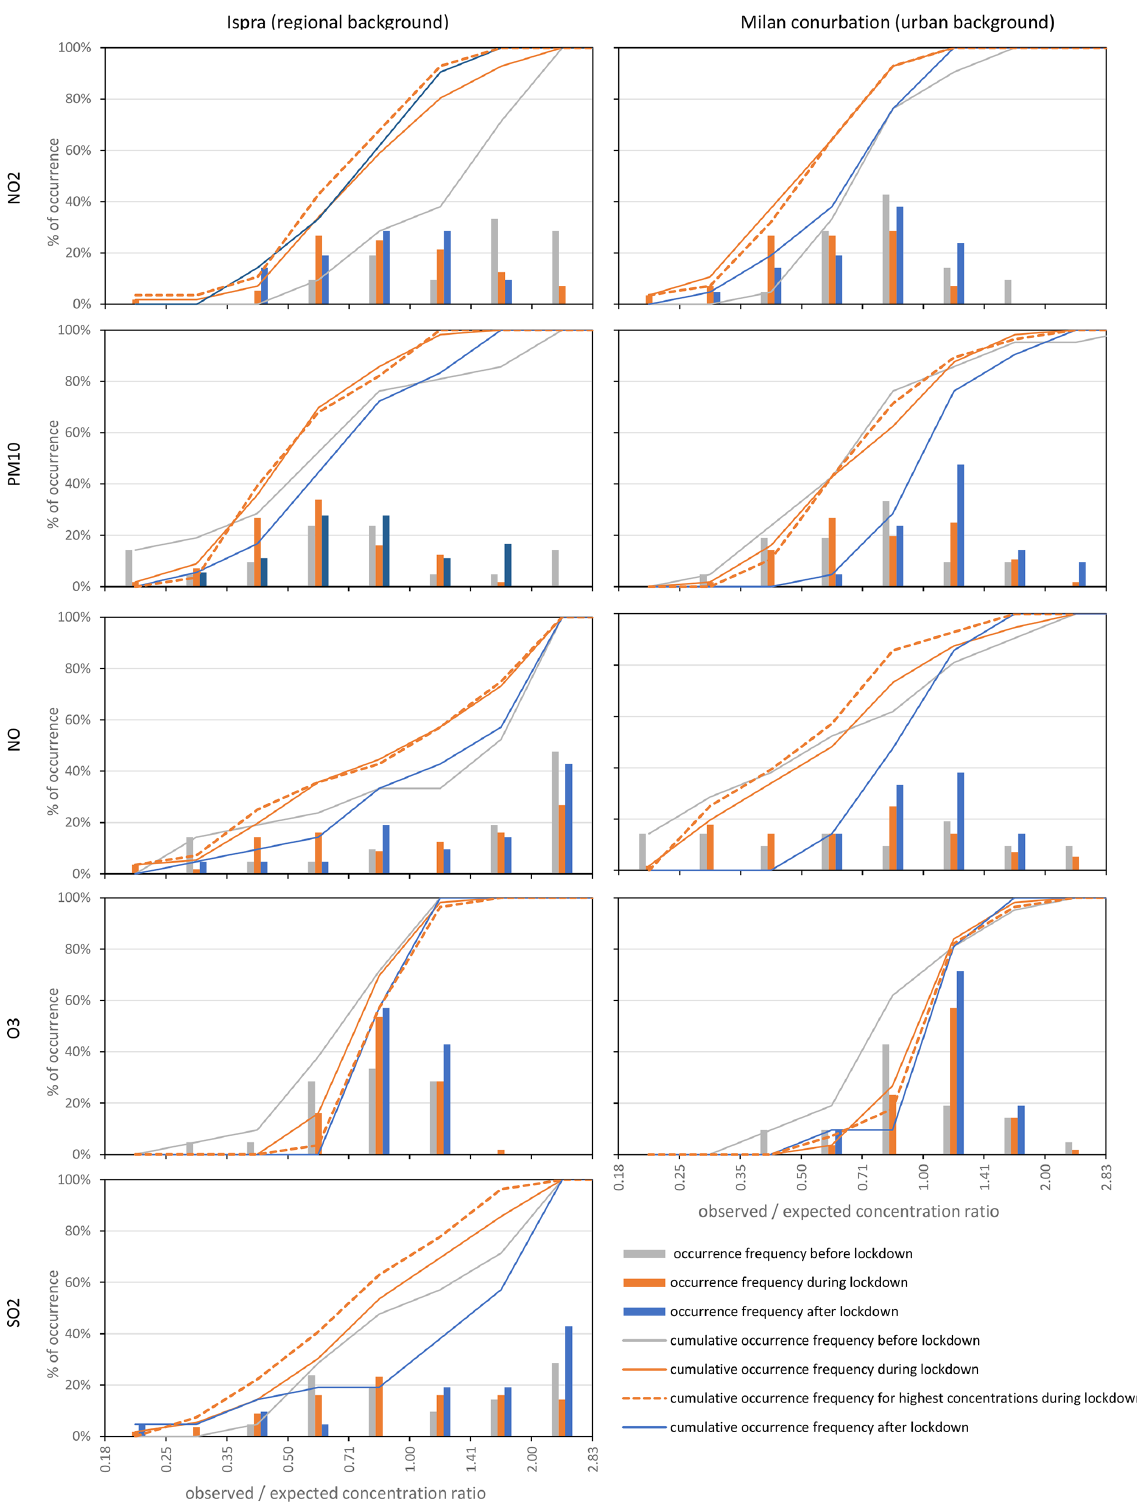
Figure 4. Occurrence frequency distributions of 2020 observed / expected concentration ratios (Obs 2020 / Exp 2020 ) for NO 2 , PM 10 , NO, O 3 and SO 2 during the lockdown period and during the 3 weeks before and after the lockdown period in Ispra (left) and the Milan conurbation (right). Lines show cumulative frequencies of occurrence. Dashed lines show the cumulative frequency of occurrence of Obs 2020 / Exp 2020 ratios for the 28d corresponding to the highest CAMS forecast values. Note: the last bin for NO in Ispra contains all values > 2. Atmos. Chem. Phys., 21, 7597–7609, 2021